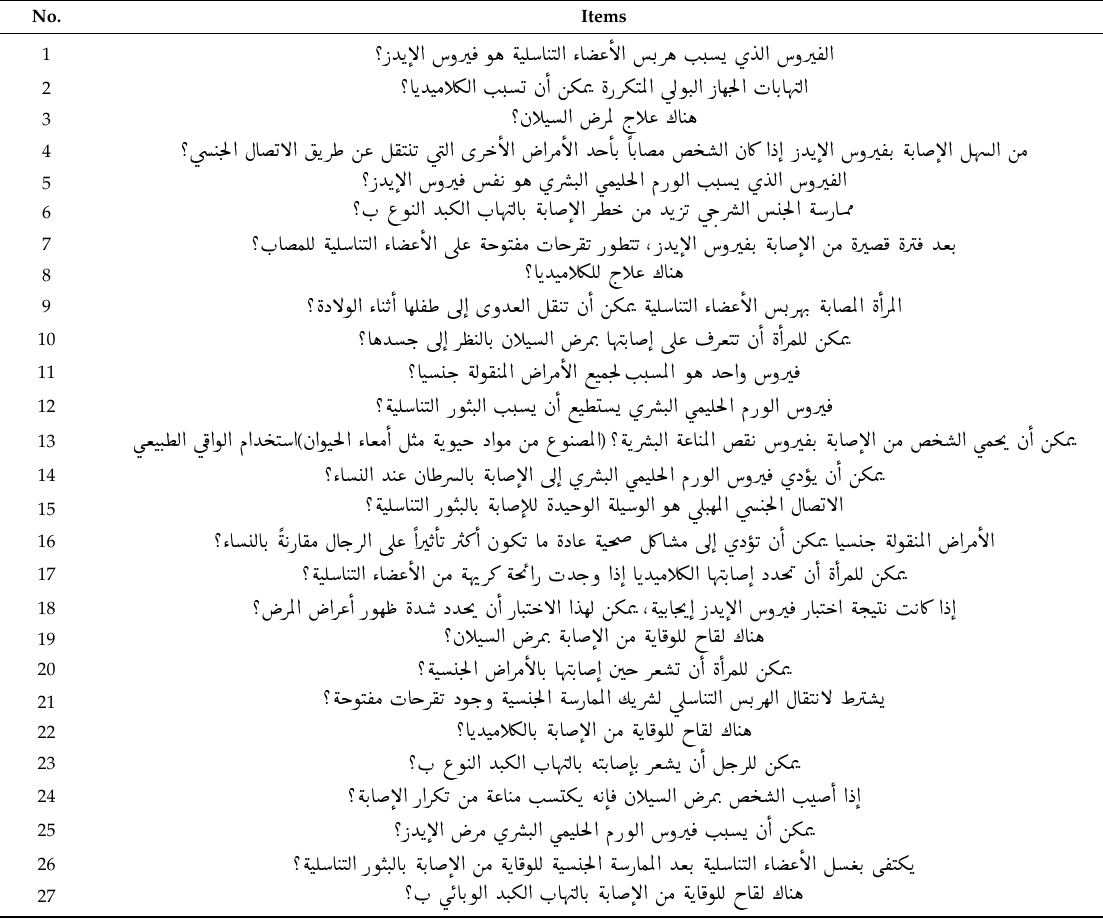
Table A1. Arabic-translated version of the sexually transmitted disease knowledge questionnaire developed and applied by Jaworski and Carey in 2007